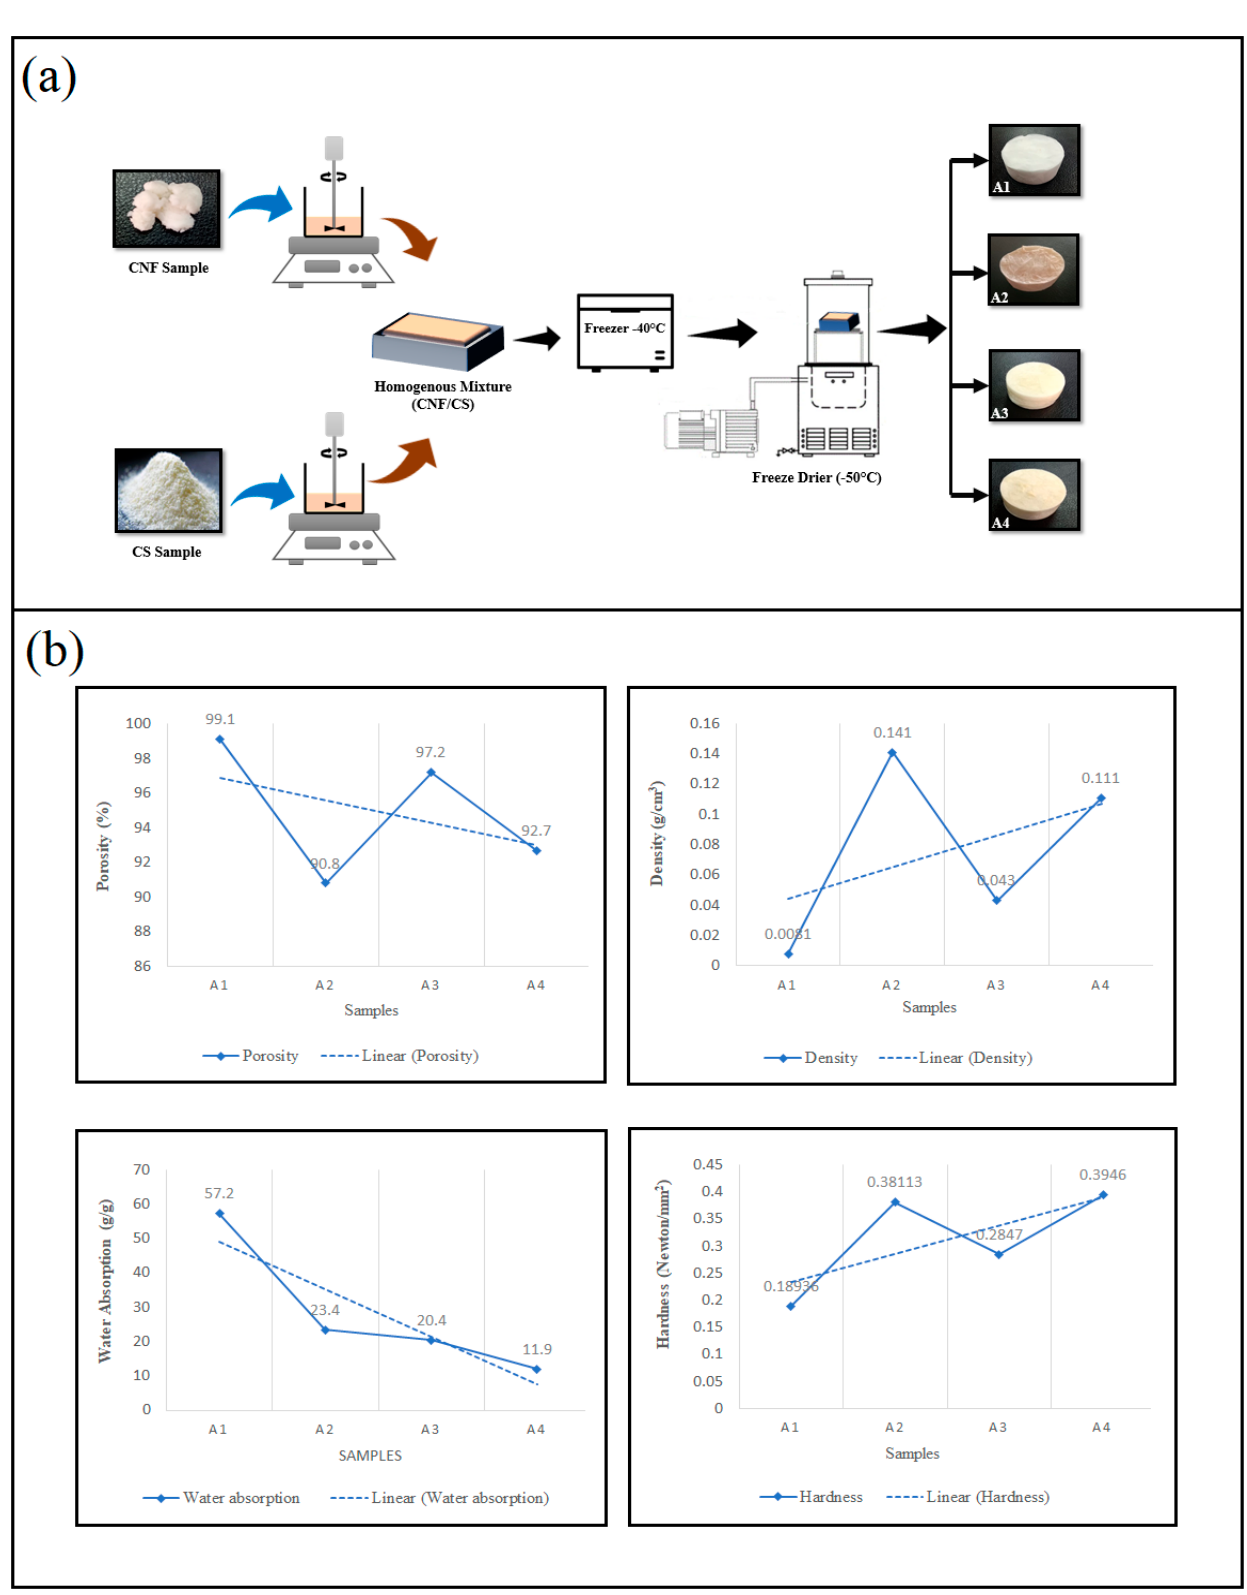
Figure 1. Properties of CNFs and CS aerogels: ( a ) the overall preparation procedure and ( b ) the morphological analysis of the four samples (density, porosity, water absorption and hardness); A1 = pure CNFs aerogel, A2 = pure CS aerogel, A3 = 60/40 CNFs/CS aerogel and A4 = 40/60 CNFs/CS